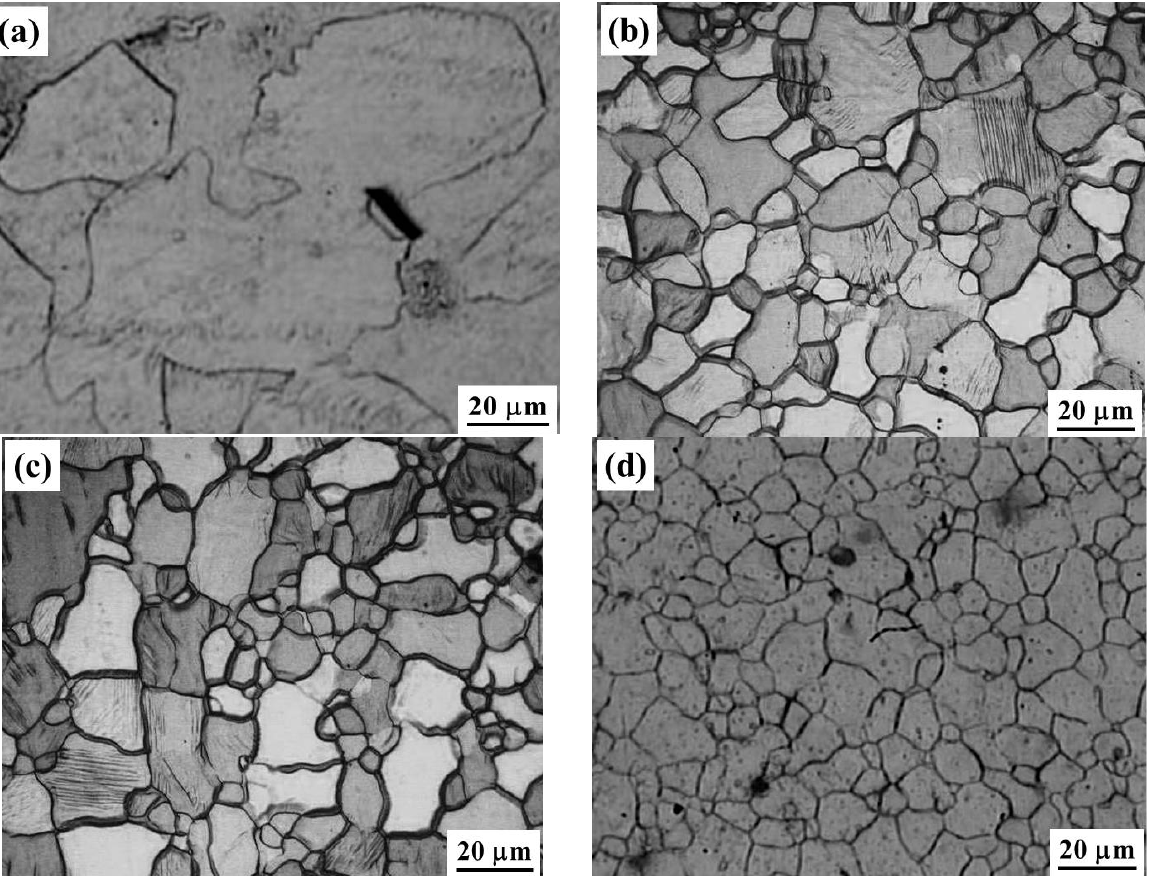
Figure 1. Microstructures obtained on AZ31: ( a ) cast-homogenized condition; extruded at: ( b ) 300 °C; ( c ) 350 °C; and ( d ) 450 °C.